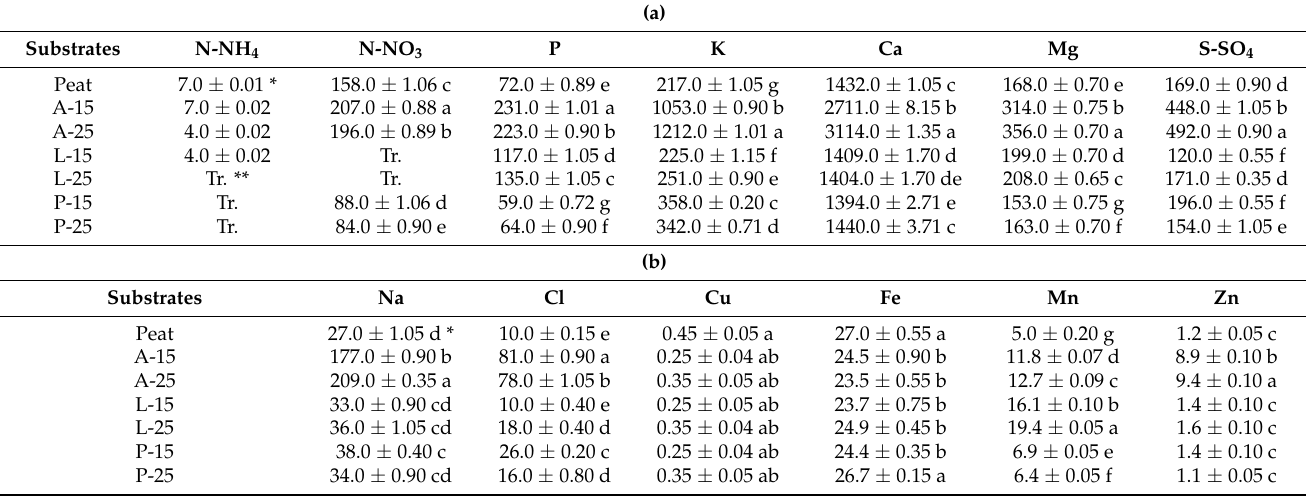
Table 5. ( a ) Macronutrient concentrations in different substrates before strawberry cultivation (mg · dm 3 ). ( b ) Micronutrient concentrations in different substrates before strawberry cultivation (mg · dm 3